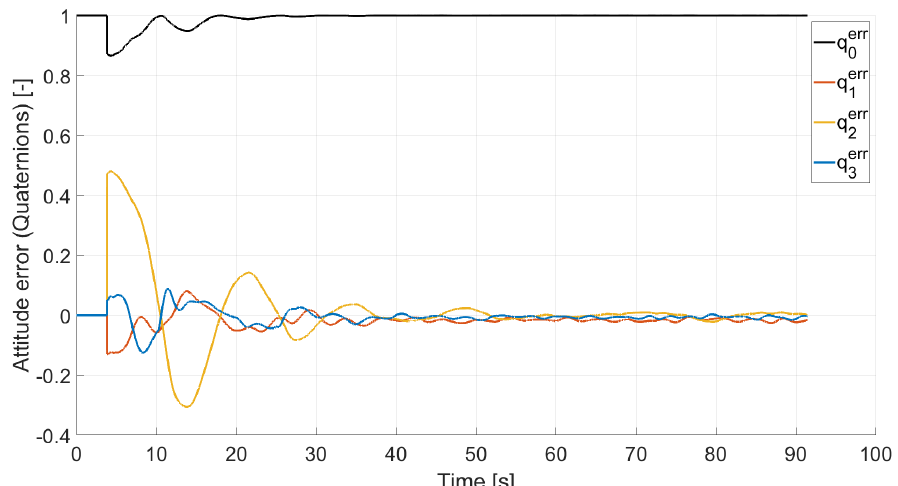
Figure 19. Case 2: quaternion error.